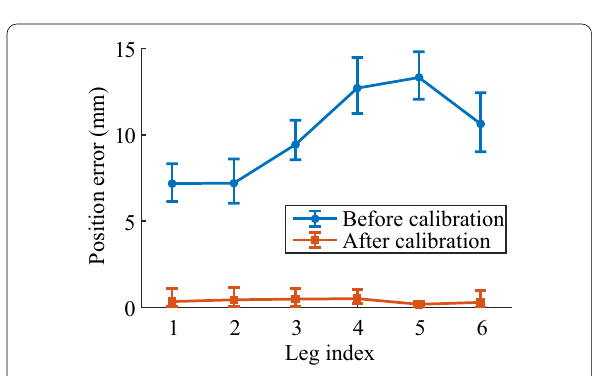
Figure 15 Position errors of each foot-tip